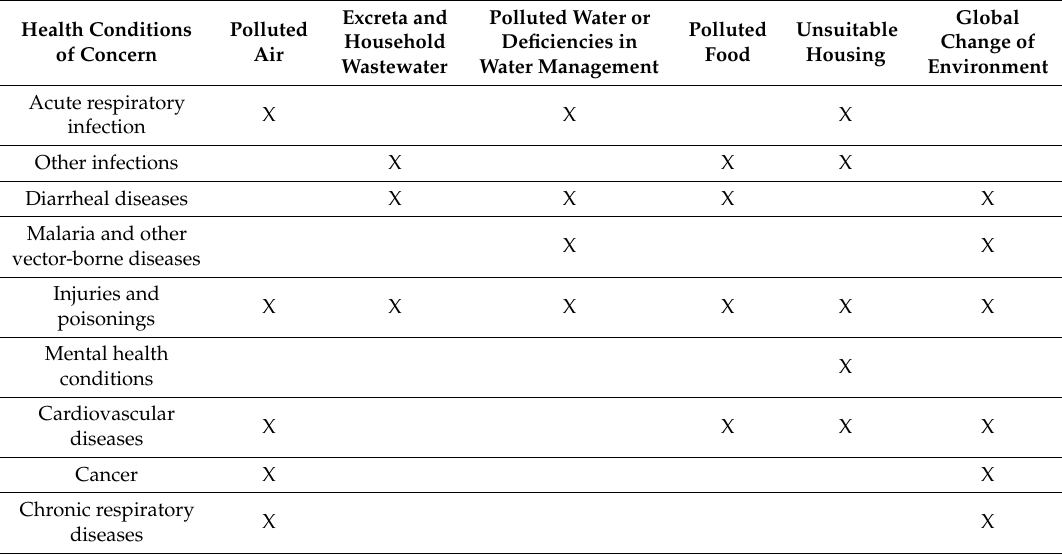
Table 3. Potentially strong relationships between exposure situations and health conditions relevant to agricultural food production and storage (based on this literature review and the expert opinions of the